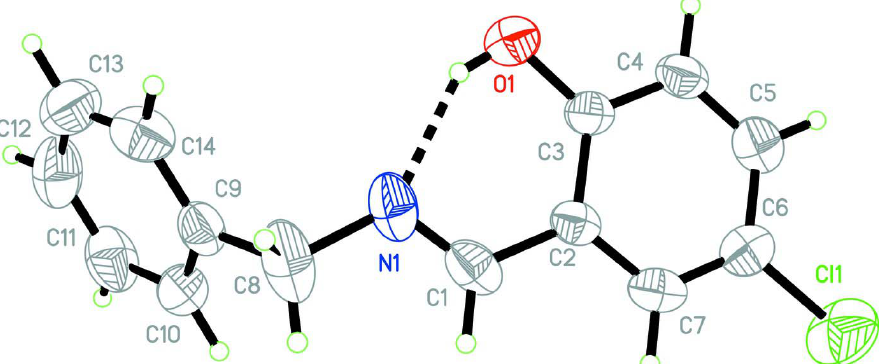
The structure of the title compound with 30% probability displacement ellipsoids. H atoms are shown as spheres of arbitrary radii. The dotted line represent a hydrogen